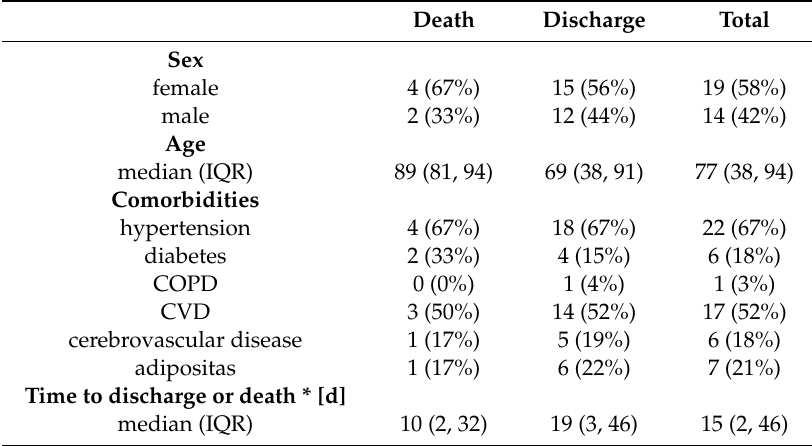
Table 1. Characteristics of the COVID-19 patients contributing to this study.